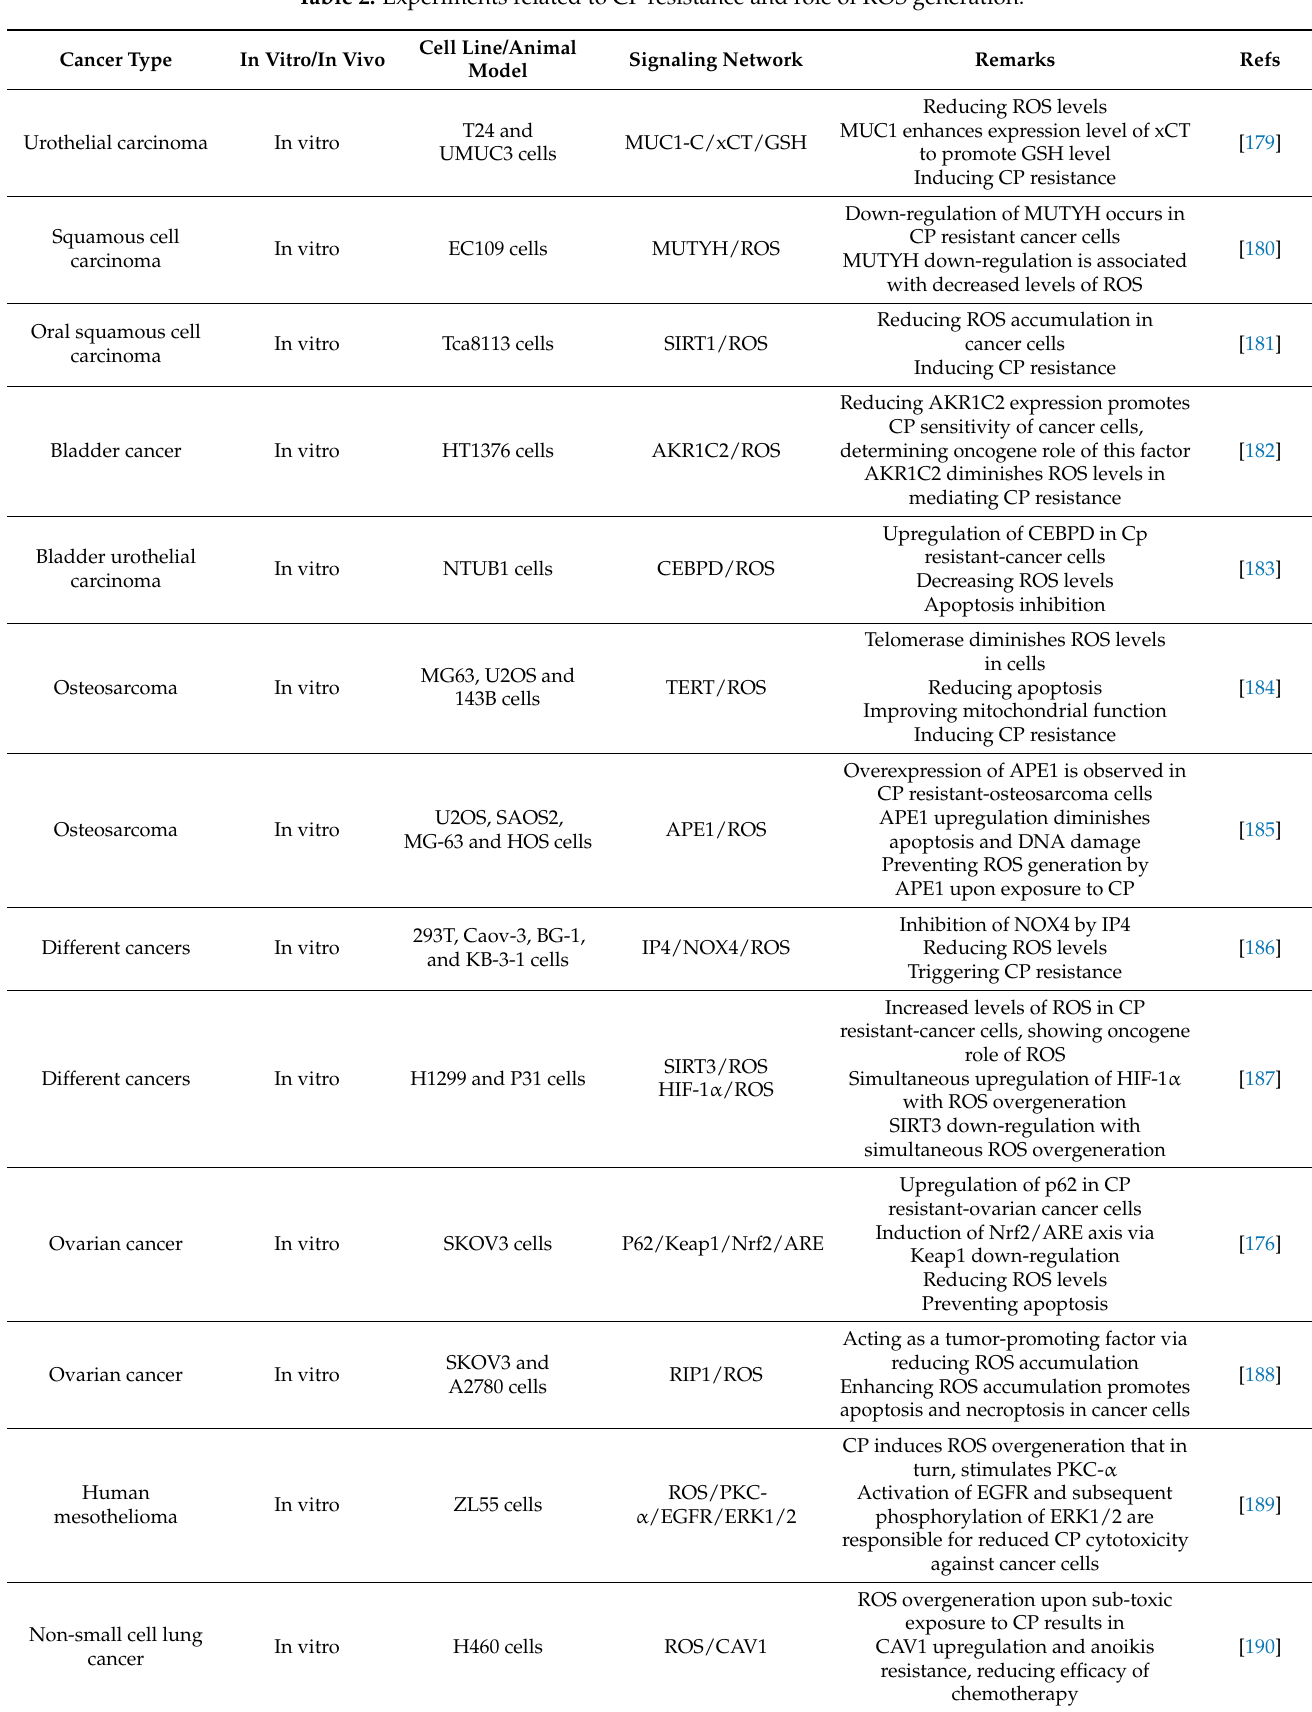
Table 2. Experiments related to CP resistance and role of ROS